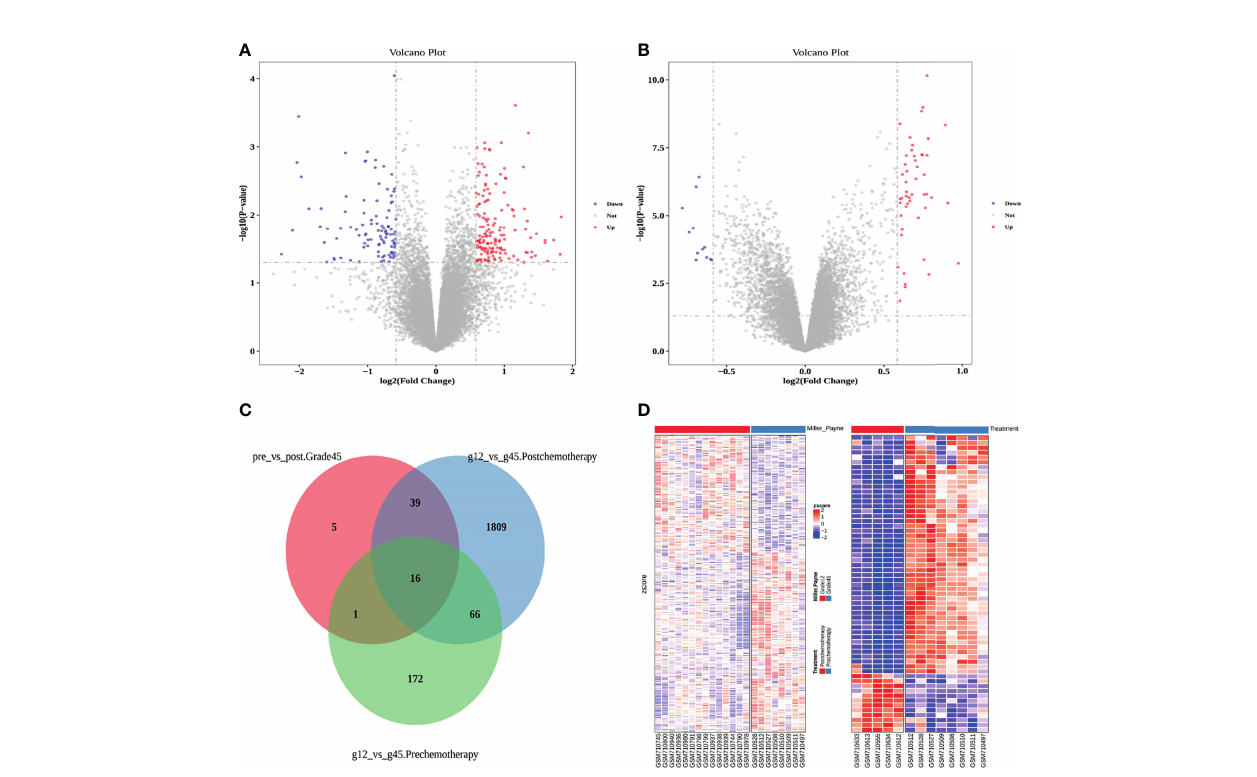
FIGURE 1 | (A) Differentially expressed genes in Grade12 versus Grade45 before chemotherapy. (B) Grade45 differentially expressed genes before and after chemotherapy. (C) A Venn diagram of each group of samples comparing differentially expressed genes. (D) Comparison of Zscore for differential gene expression, Grade12 vs. Grade45 on the left and before and after treatment on the